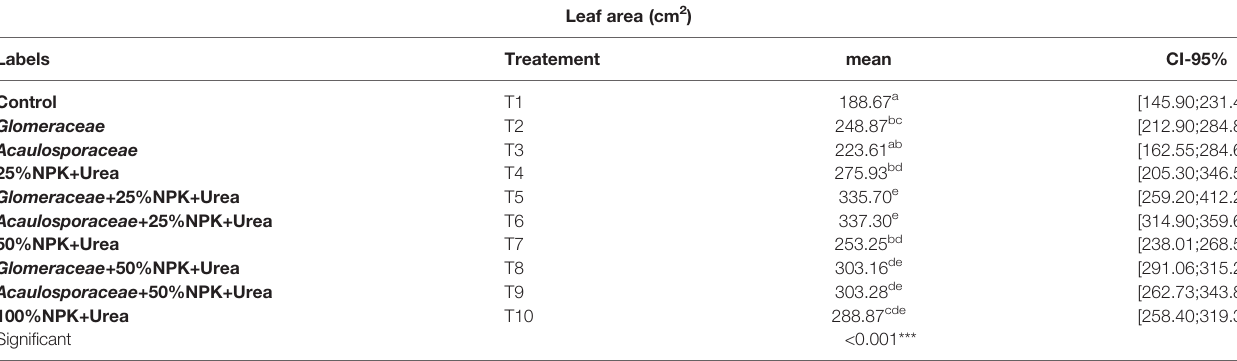
TABLE 4 | Average leaf area per treatment (CI-95%: Con fi dence Intervals).